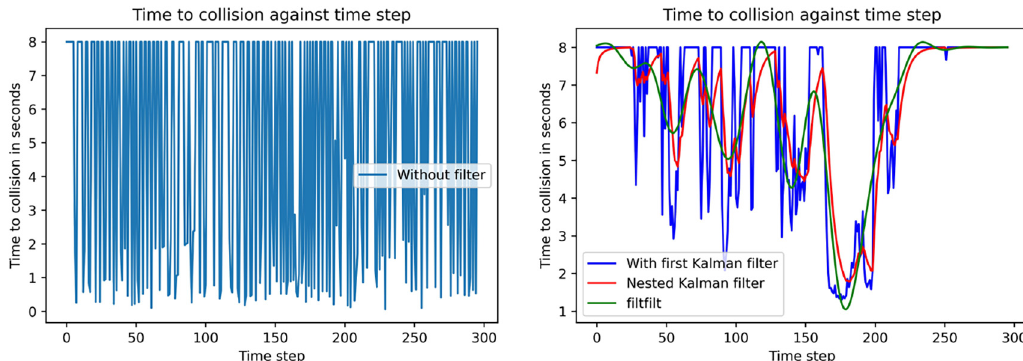
Figure 4 Time-to-collision without using any fi lter (Left) and with nested Kalman fi lter (Right)